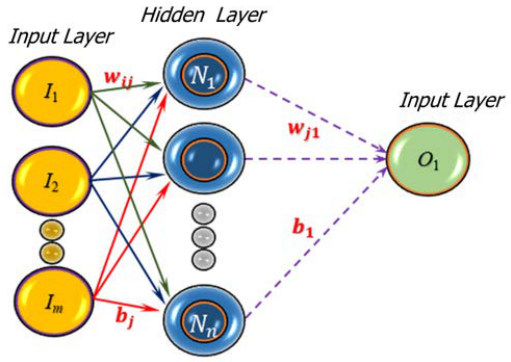
Figure 1. ANN architecture.